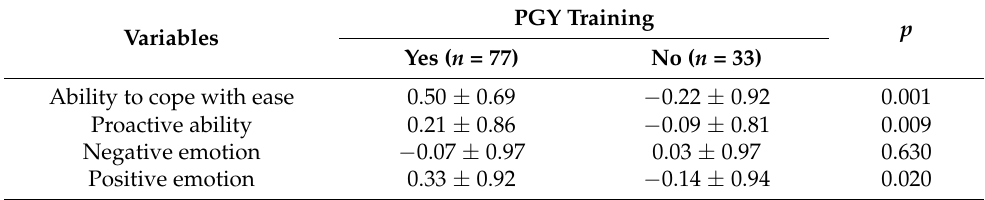
Table 3. Measurement of the self-efficacy and emotional traits of subjects with or without PGY training in coping with the COVID-19 pandemic. The results were expressed as mean ± standard deviation